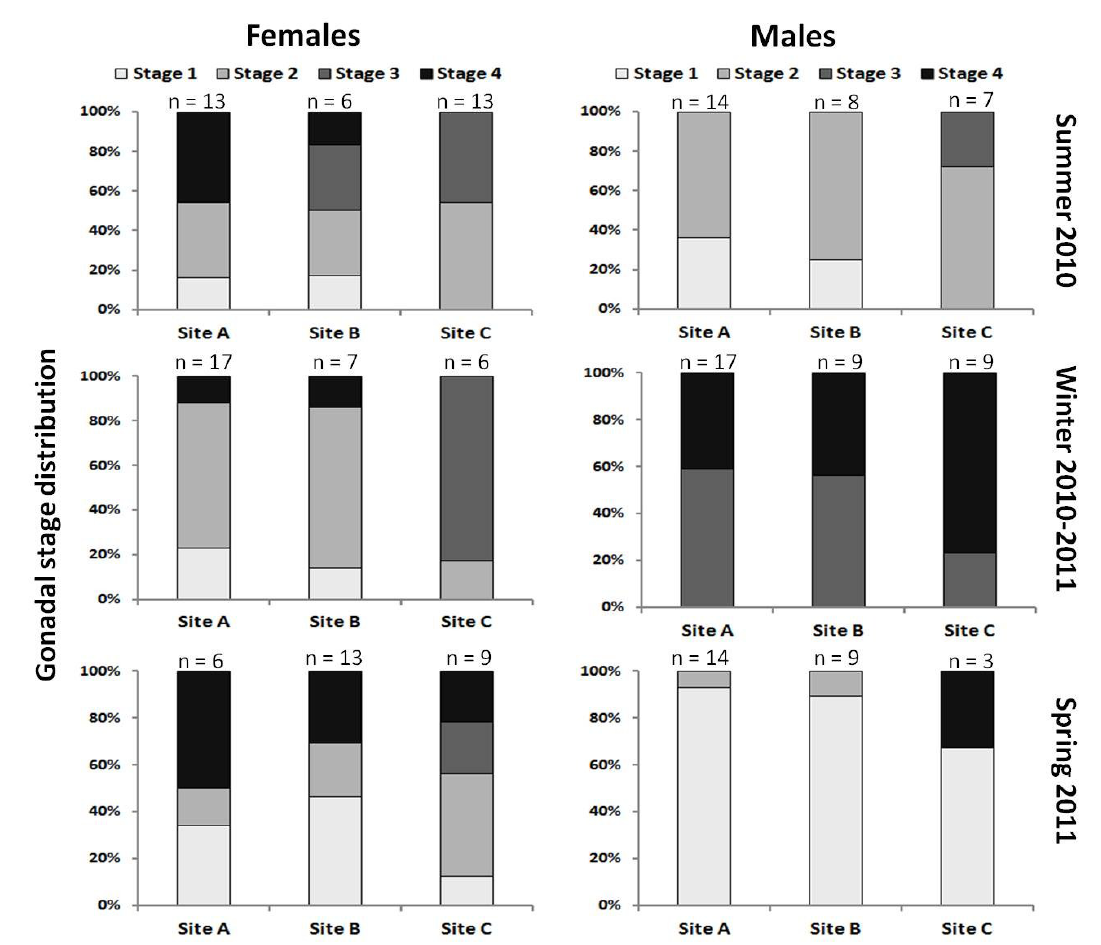
Figure 1. Distribution of the gonadal development stages in female and male mullets sampled in Summer 2010, Winter 2010–2011 and Spring 2011 from the Tiber river site A and B, and from the uncontaminated reference site C. In female mullets: stage 1 = primary oocytes, stage 2 = pre-vitellogenic oocytes, stage 3 = secondary oocytes and stage 4 = degenerated oocytes. In male mullets: stage 1 = spermatogonia, stage 2 = spermatocytes, stage 3 = spermatids and stage 4 =